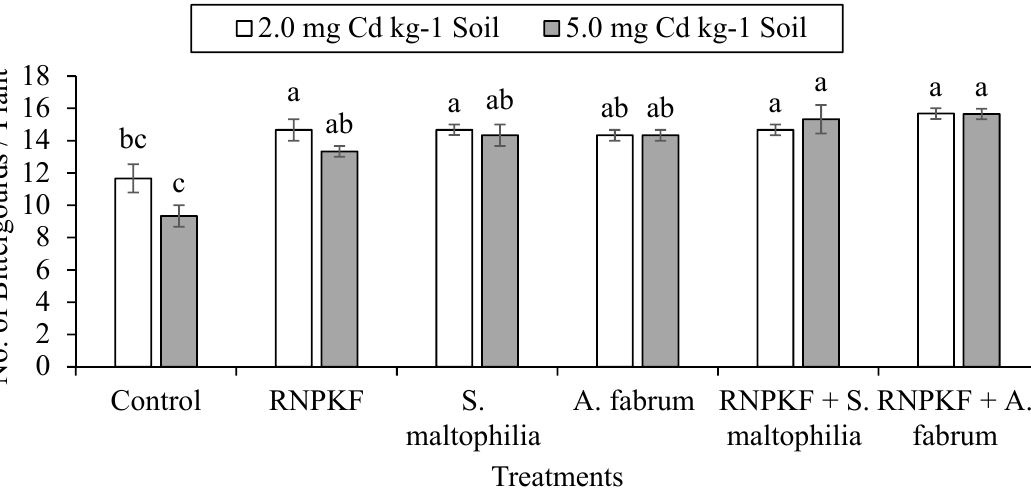
Figure 1. Number of bitter gourds per plant (BDP) treated with plant growth promoting rhizobacteria (PGPRs), recommended NPK fertilizers (RNPKF), and their combination under 2 and 5 mg Cd kg − 1 soil. Different small letters express significant differences ( p ≤ 0.05).